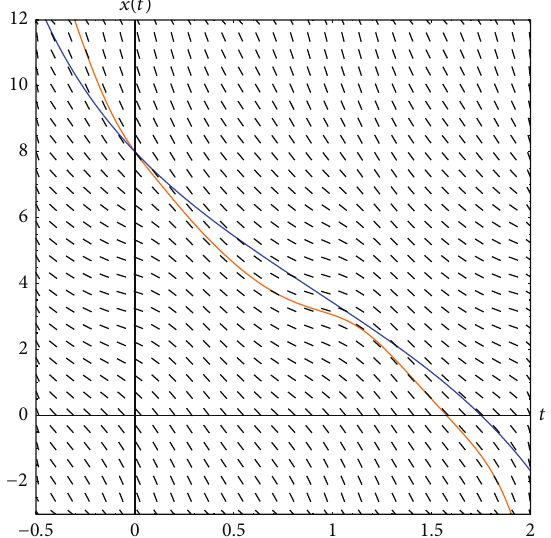
Figure 4: The upper solution (blue) and solution (orange) to (35) satisfying the initial condition 𝑥(0) = 8 . An upper bound for the = 1.7506 . extinction time for this solution is 𝑡 l ext